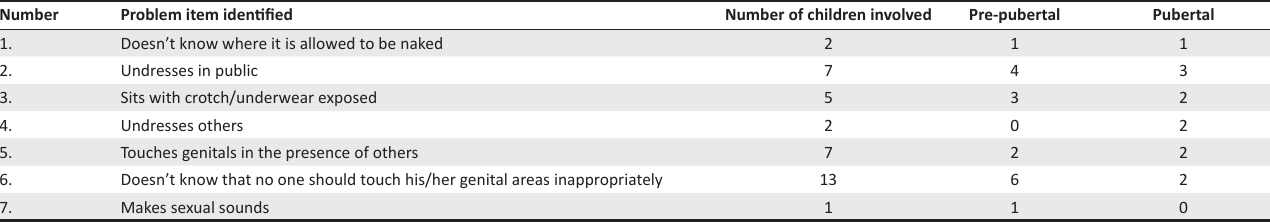
TABLE 3: Problem item identified regarding socio-sexual skills. Number